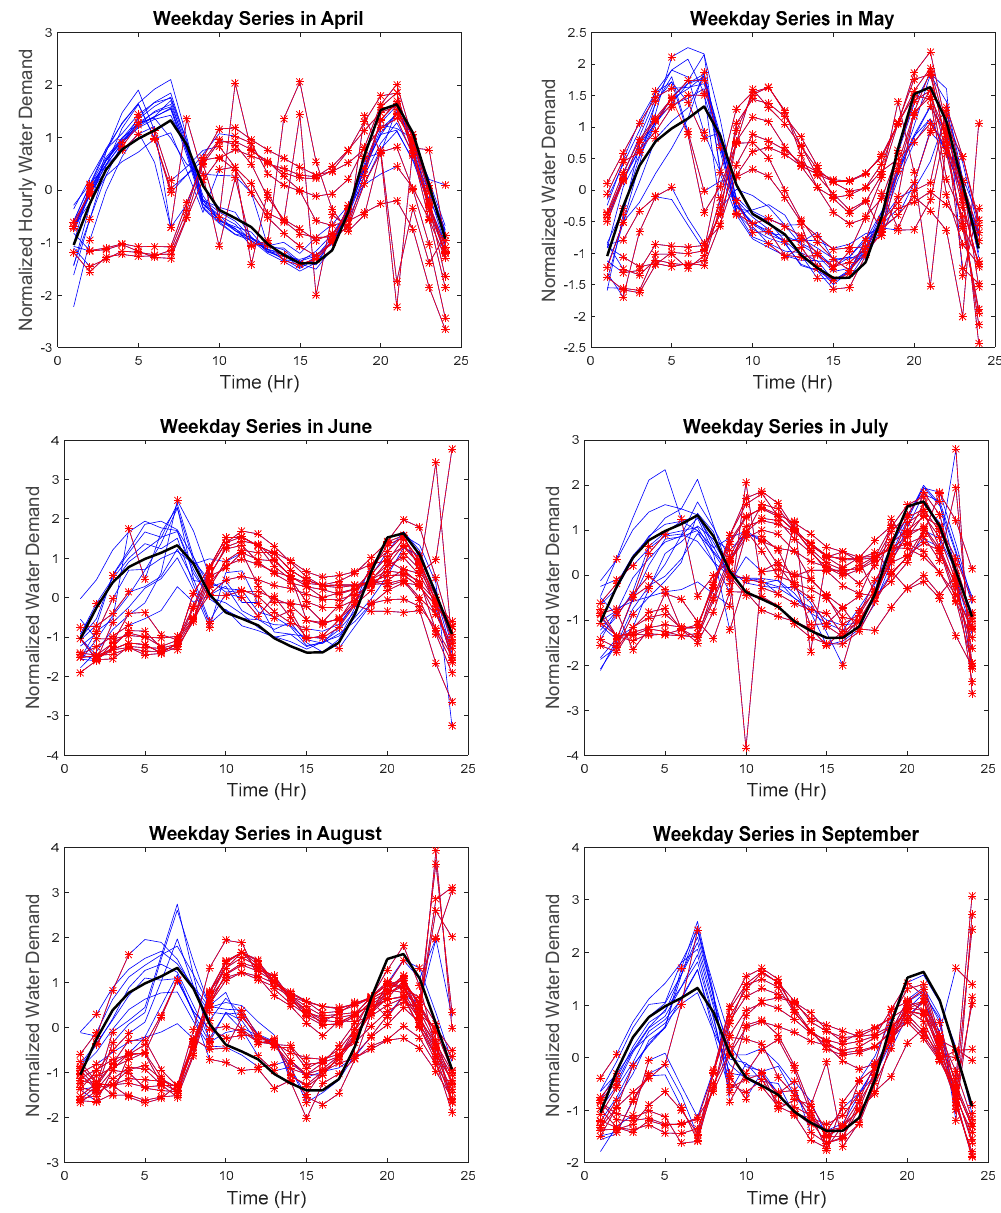
Figure 10. Normalized weekday series with detected anomalies (April–September).